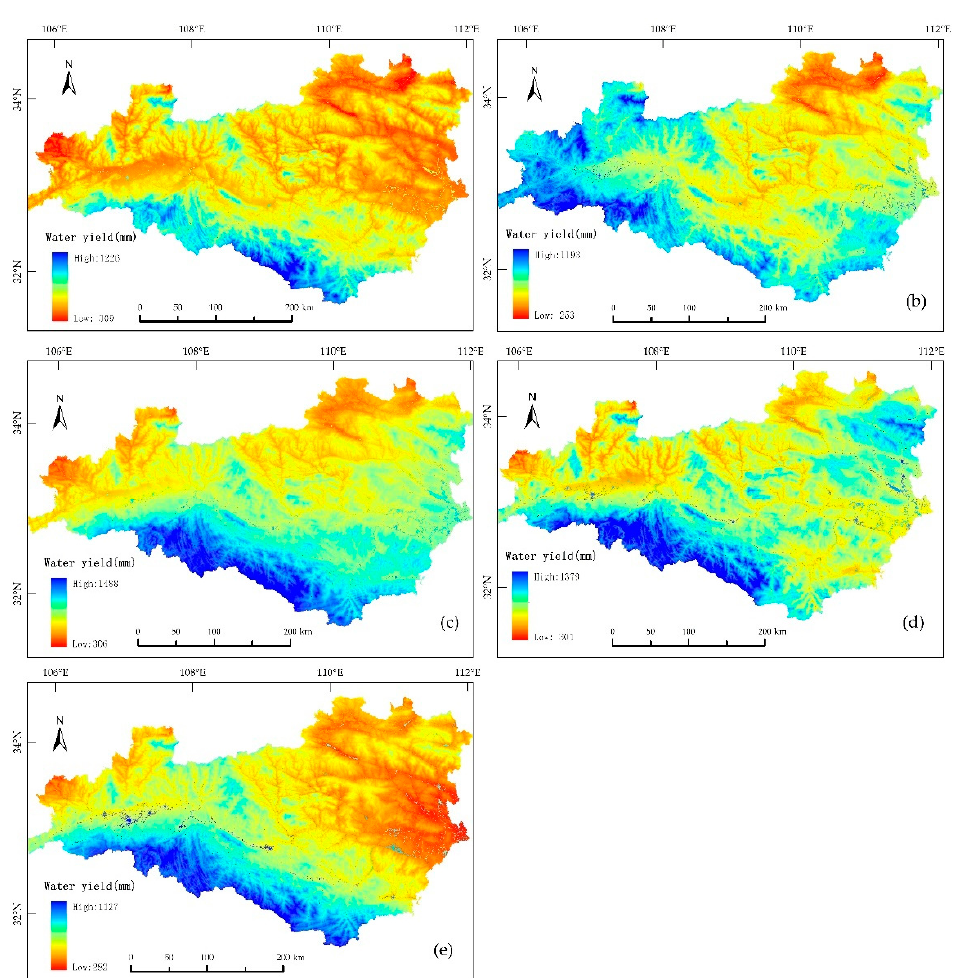
Figure 6. The spatial pattern distribution of water producing depth in the water source region during 1985–2020. ( a ~ e ) represent the distribution of water yield in the water source region in 1985, 1990, 2000, 2010 and 2020, respectively.